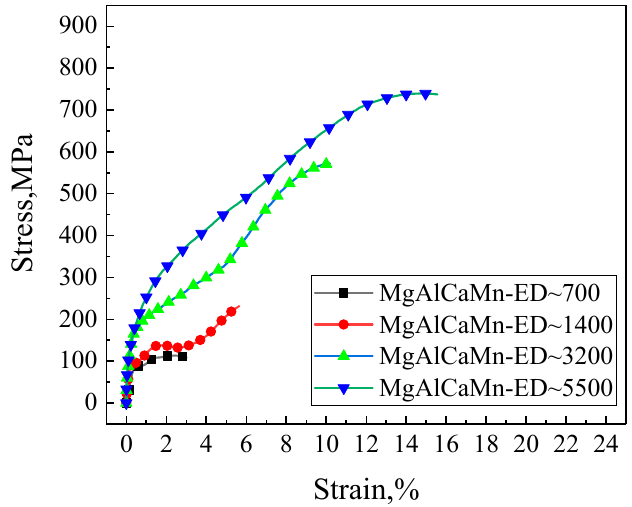
Figure 6. Stress–strain curve of Mg-Al-Ca-Mn alloy dynamically compressed in the ED direction.